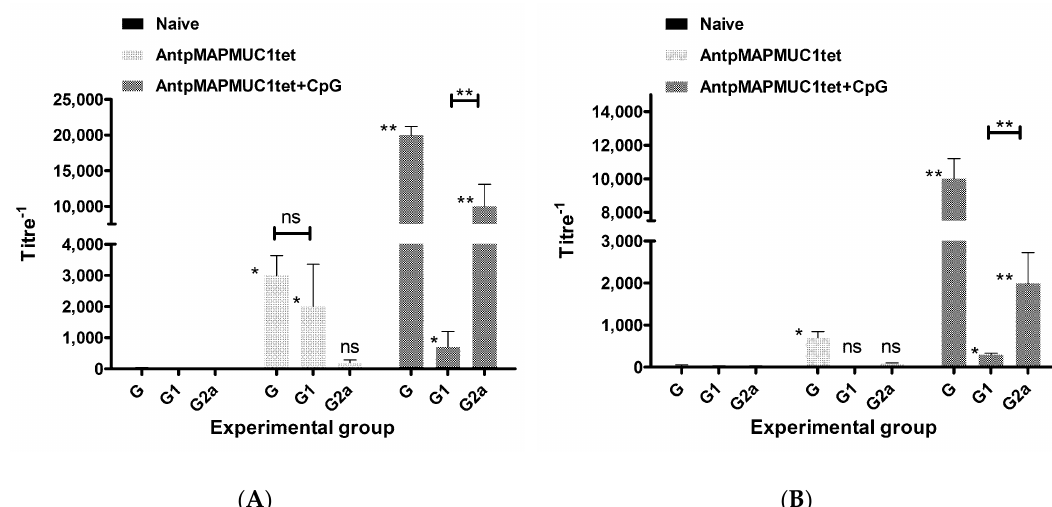
Figure 11. Short and long term MUC1-specific total IgG, IgG1 and IgG2a subclass antibody responses. C57BL/6 mice were injected on day 0, 10 and 17 i.d. with PBS, 100 µg AntpMAPMUC1tet or 100 µg AntpMAPMUC1tet + 50 µg CpG and 14 days after last immunisation mice (short term) ( A ) or 40 days after the last immunisation (long term) ( B ) were bled and total IgG, IgG1 and IgG2a antibody responses to Cp13-32 (MUC1 VNTR) were determined via ELISA. Data presented as mean titre ± SEM ( n = 4). Statistical difference compared to naïve mice: * p < 0.05; ** p < 0.001.